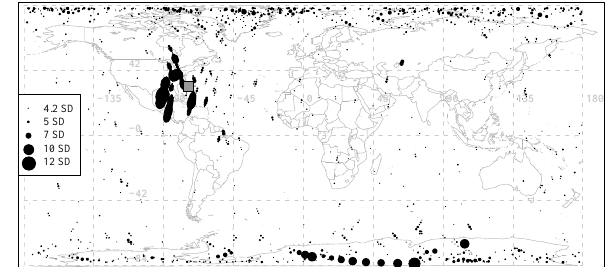
Fig. 4. Map of detected points. A point is shown if it is more than 4 standard deviations above the mean as described in the text and shown in Fig. 3. Dot size is proportional to the amount by which 4 standard deviations (SD) is exceeded. The grey square marks 31.5 ◦ N, 74 ◦ E, which we assume to be the release point of the plume.